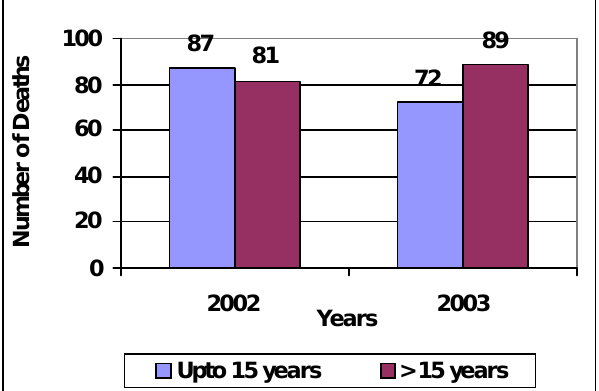
Fig. 8 : JE Deaths: Age Group, 2002 - 2003